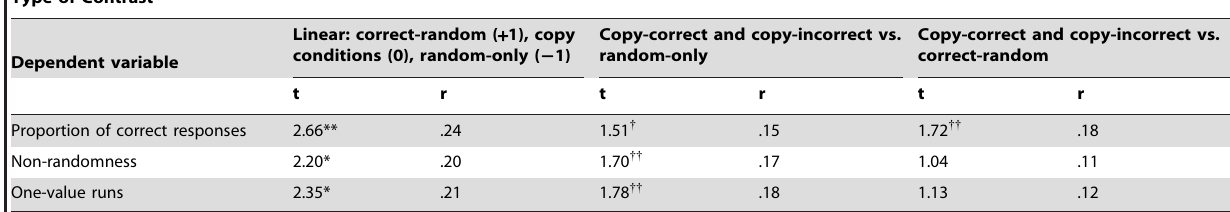
Table 2. t-tests of Contrasts Among Conditions (Experiment 2).